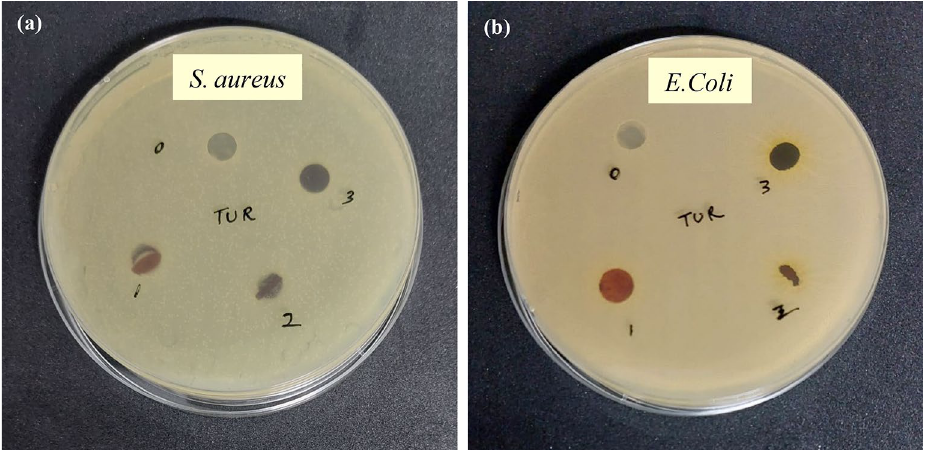
Figure 12. Photograph of antibacterial activity of zeolite loaded PVA/CMC/TUR films against ( a ) gram- positive ( S. aureus ) and ( b ) gram-negative ( E. coli ) bacteria: (0) PCT-0 (1) PCT-1 (2) PCT-2 (3) PCT-3.